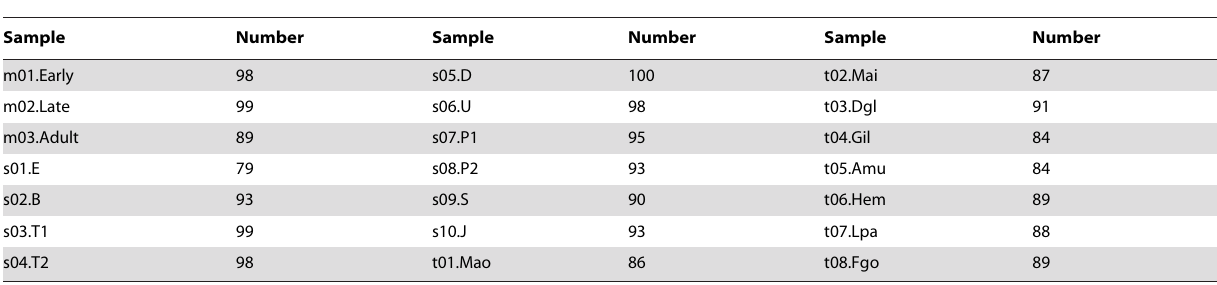
Table 1. Number of predicted precursors for each library.